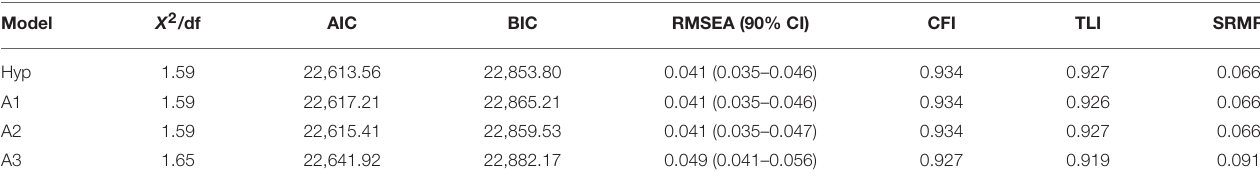
TABLE 5 | Comparison of robust fit measures for hypothesized and alternative